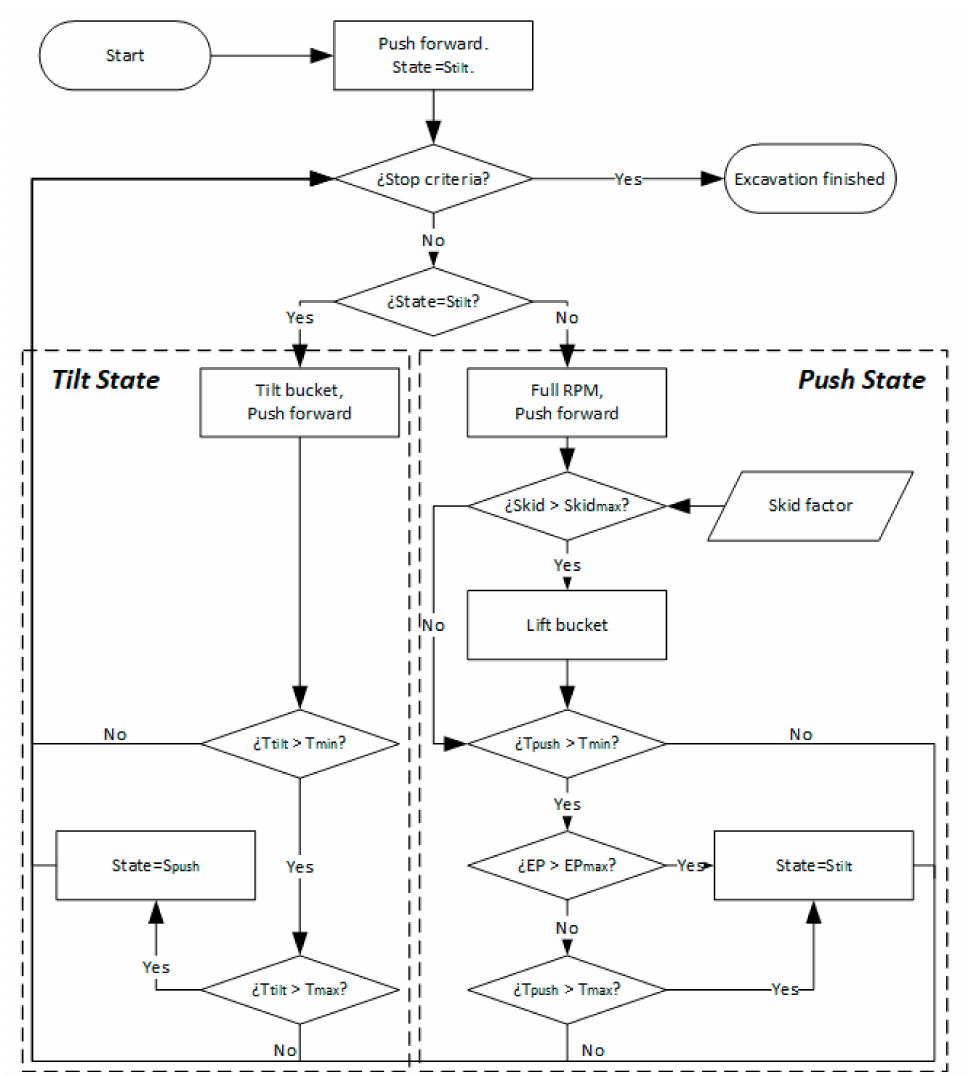
Figure 18. Flow chart of the excavation